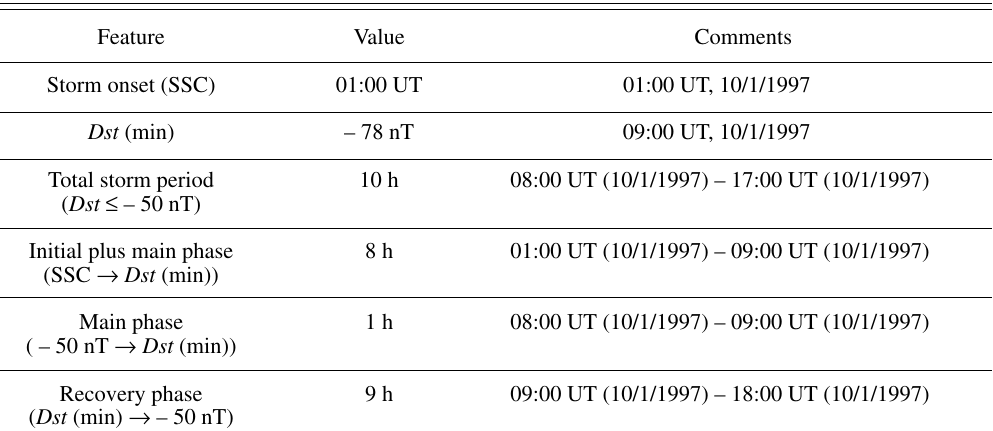
Table II. Summary of the 10th January 1997 storm